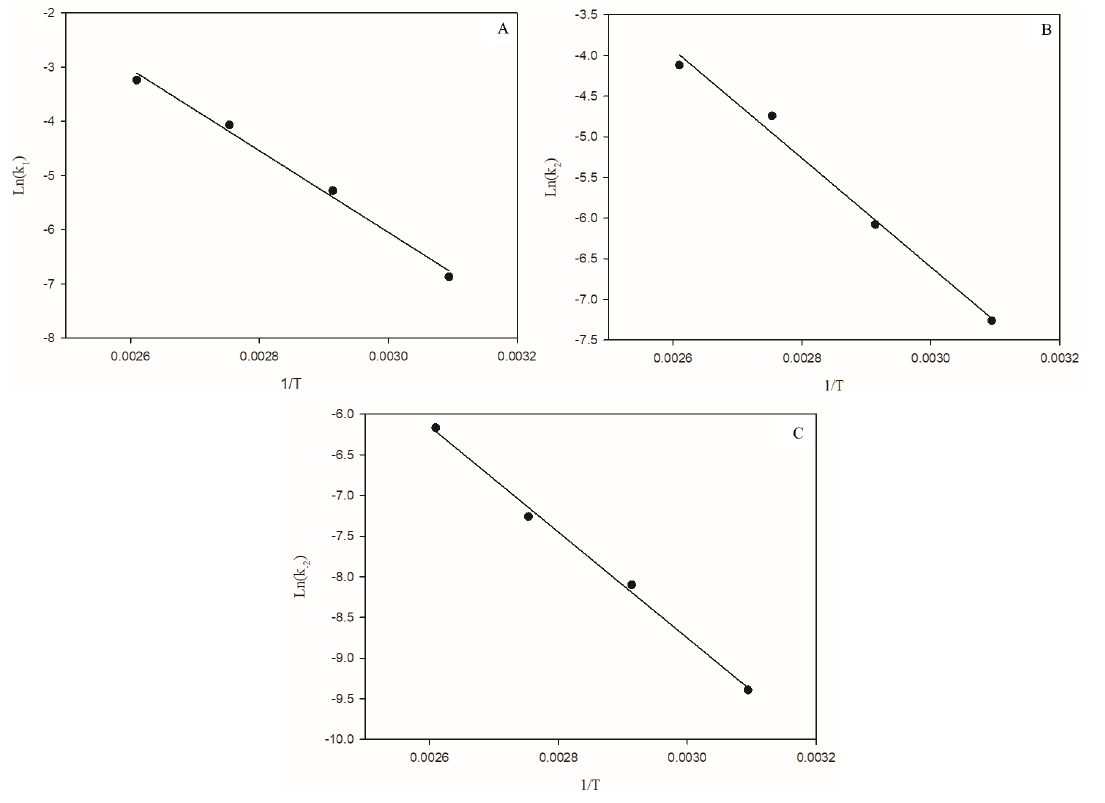
Figure 4. Arrhenius plots for EtOH experiments at 50–110 °C, line of best fit of the rate coefficients. ( A) k 1 rate coefficient, ( B) k 2 rate coefficient and ( C) k − 2 rate coefficient.